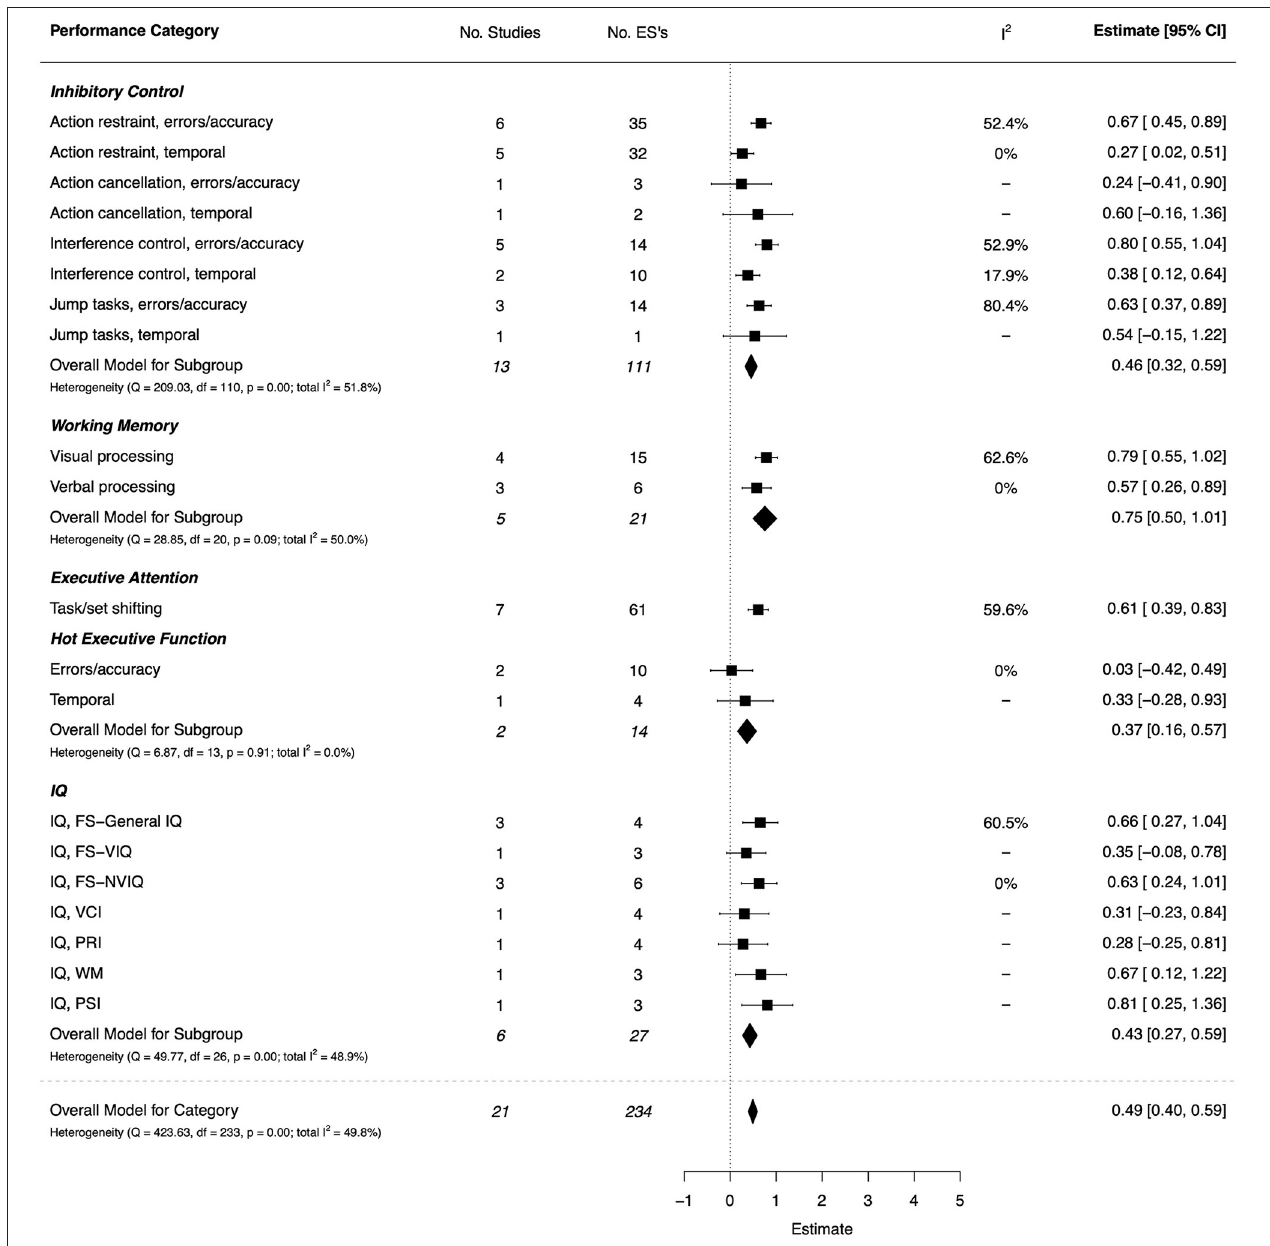
FIGURE 4 | Forest plot showing the meta-analysis results for the executive functions and intelligence factors performance category. IQ, Intelligence Quotient; FS, Full-Scale; VIQ, Verbal IQ; NVIQ, Non-Verbal IQ; VCI, Verbal Comprehension Index; PRI, Perceptual Reasoning Index; WMI, Working Memory Index; PSI, Processing Speed